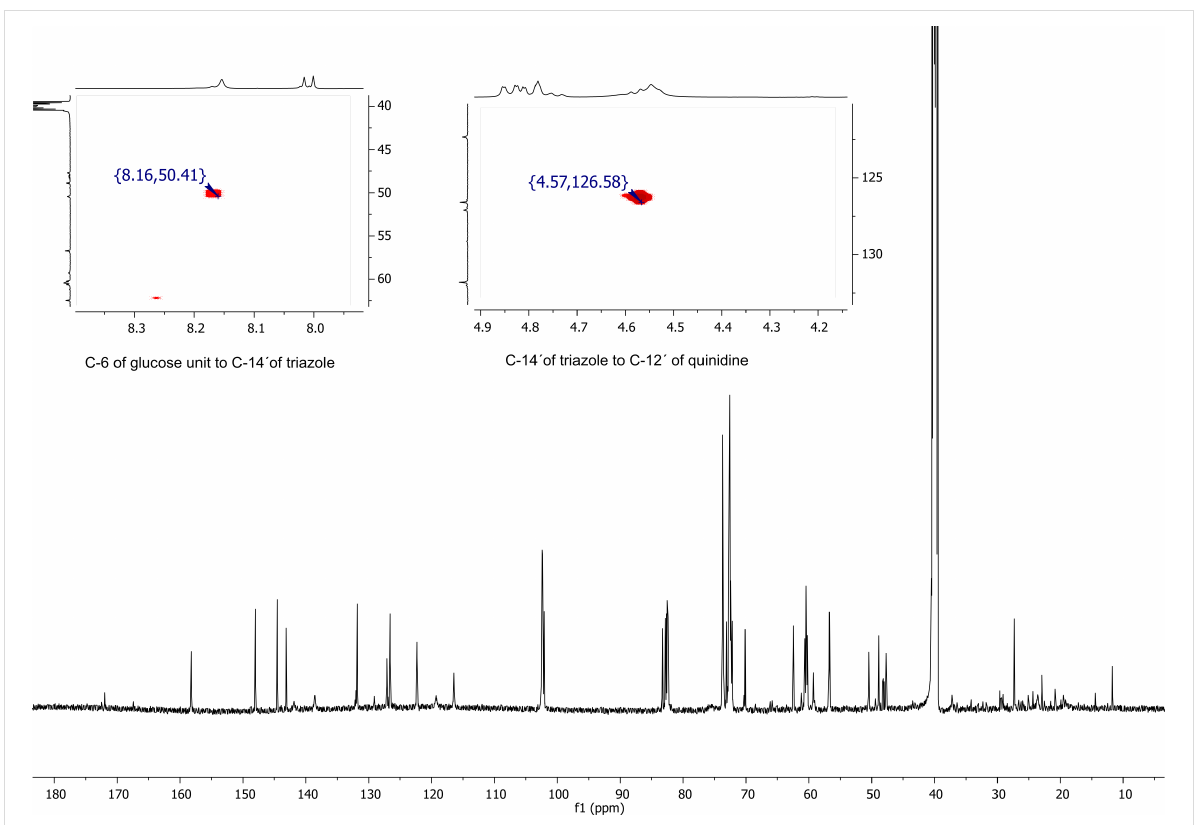
Figure 4: Representative 13 C NMR spectrum and parts of the HMBC spectrum of the non-methylated quinidine– α -CD derivative 4d .